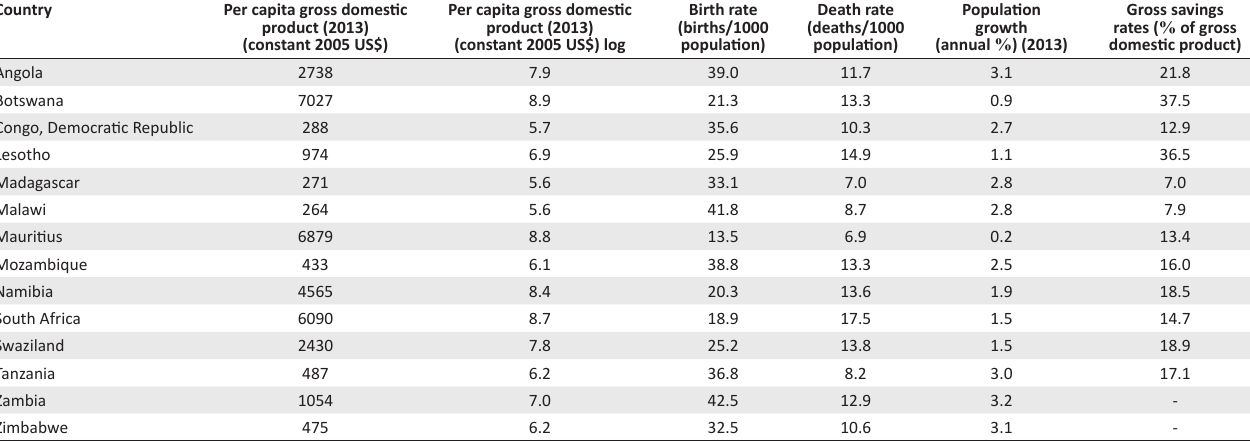
TABLE 2: Table incomes and population growth rates by 2014.